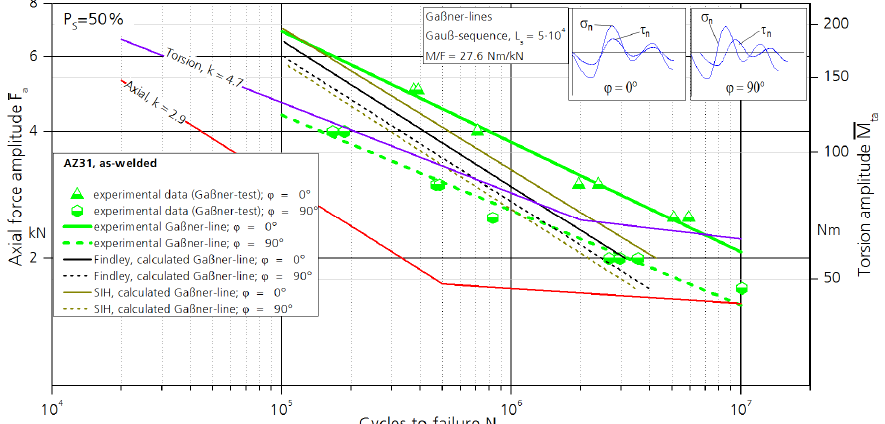
Figure 9: Experimental and computational Gassne-rlines magnesium alloy AZ31 T6 with the application of non-proportionality factors.